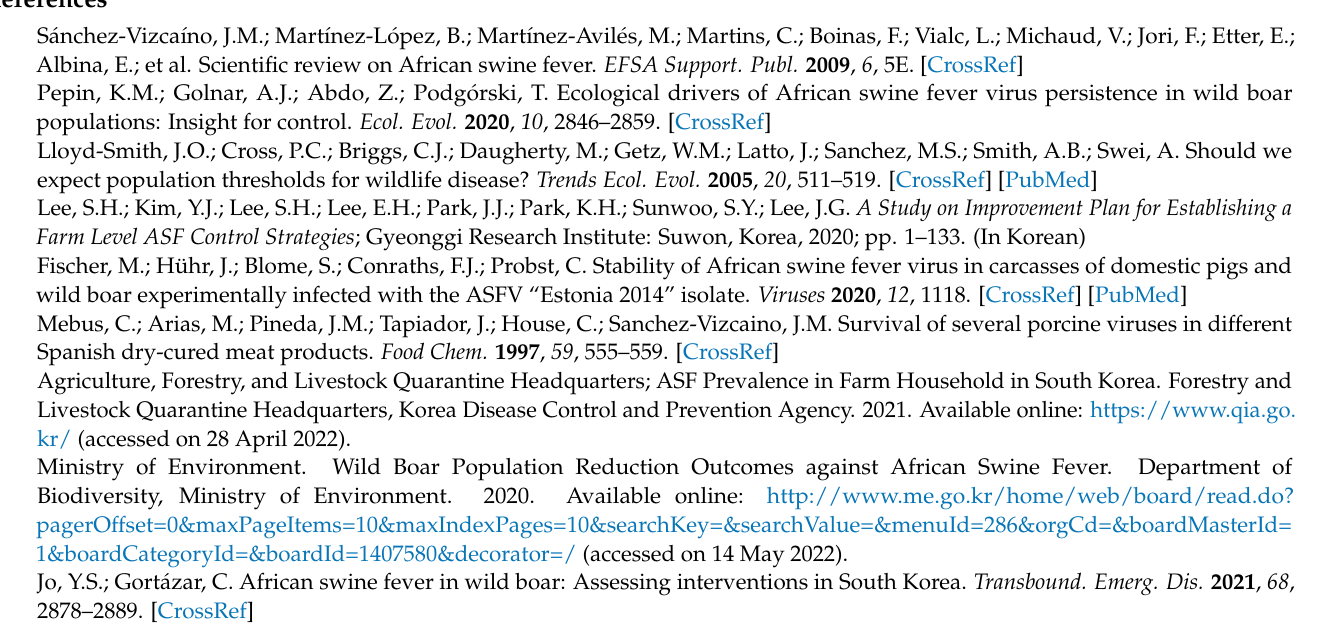
Figure S2: The results of wild boar habitat suitability (Background world), Table S1: The variables used for MaxEnt